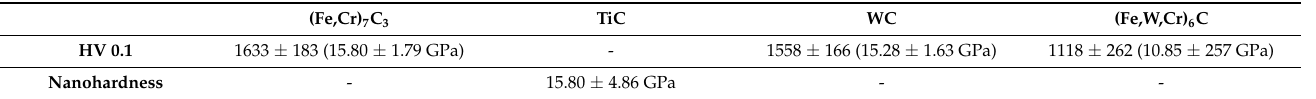
Table 2. Hardness of the carbides detected in the microstructure of the reinforced specimens.